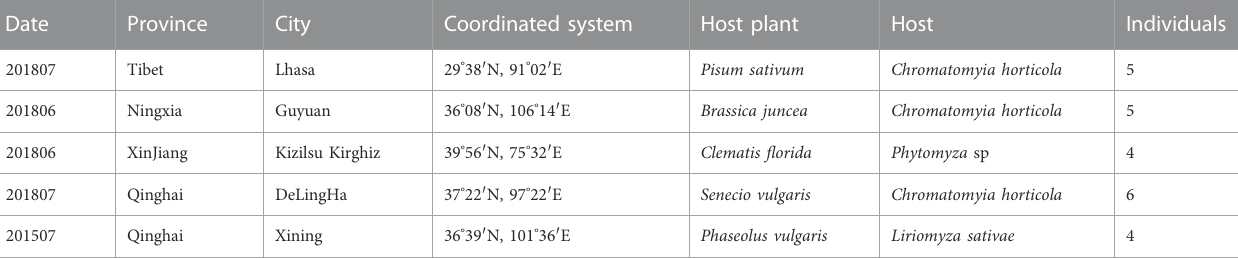
TABLE 1 Populations of thelytokous D. wani for testing polymorphisms of microsatellite